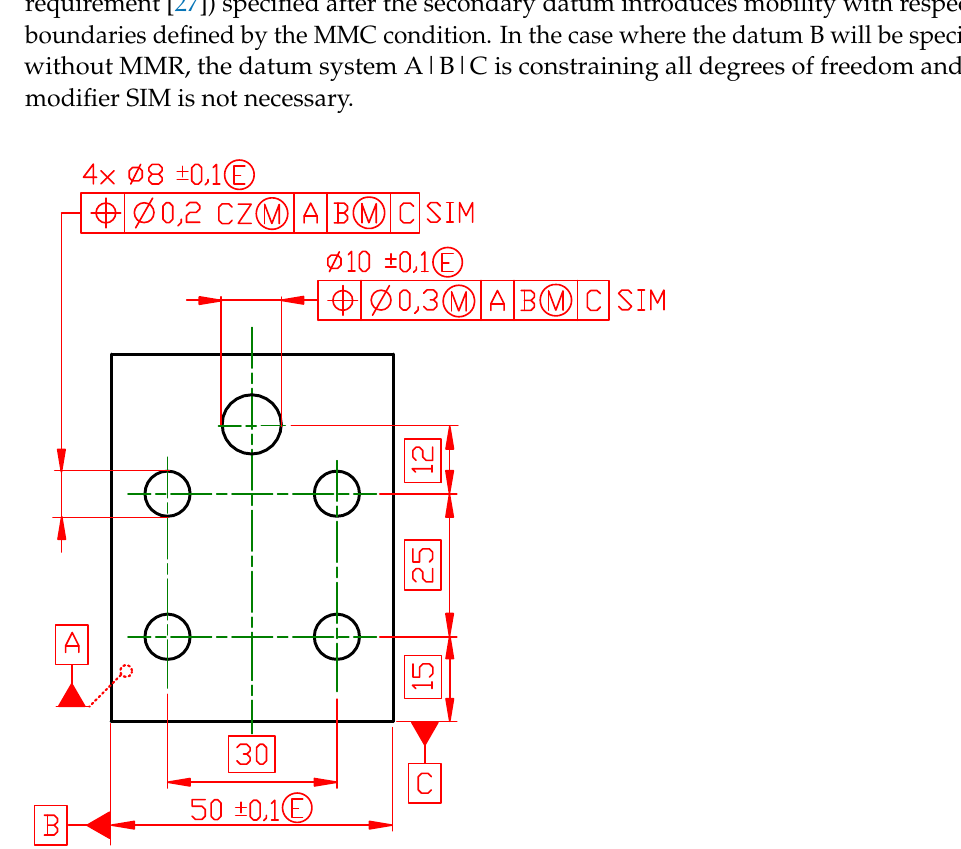
Figure 18. The ISO GPS system specification equivalent to the requirement given in Figure 17a.